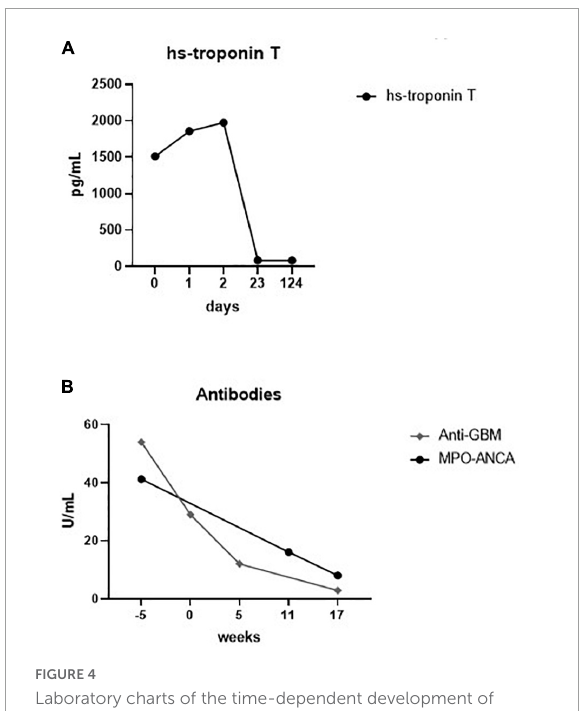
FIGURE4 Laboratory charts of the time-dependent development of high-sensitive (hs) troponin T (A) and myeloperoxidase anti-neutrophil cytoplasm (MPO-ANCA) and anti-glomerular basement membrane (anti-GBM) antibodies (B) . Zero on both scales indicates the time point of chest pain.